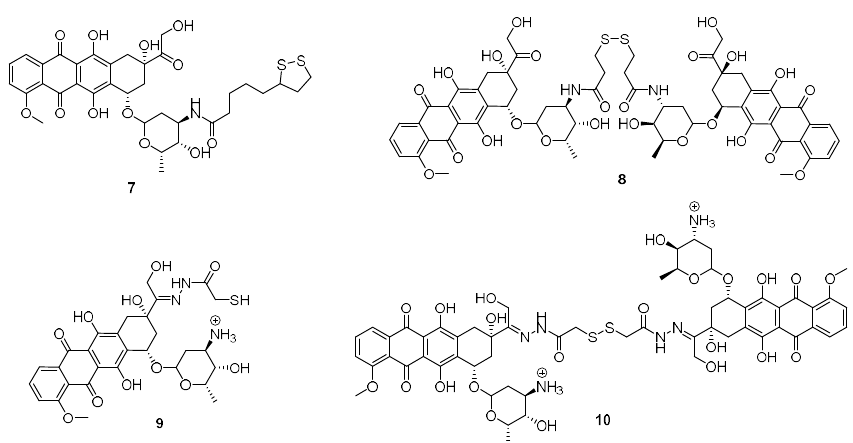
Figure 1. Structure of Doxorubicin conjugates 7 – 10 used for loading onto the CAI gold nanoparticles [13].